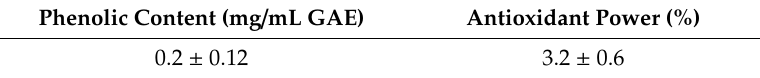
Table 3. Phenolic content and antioxidant P_PRPE membrane power of the release solution.